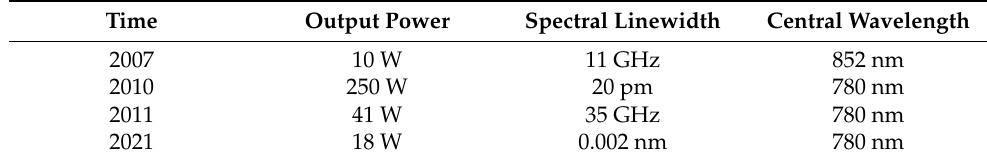
Table 1. Development of DPAL pumping